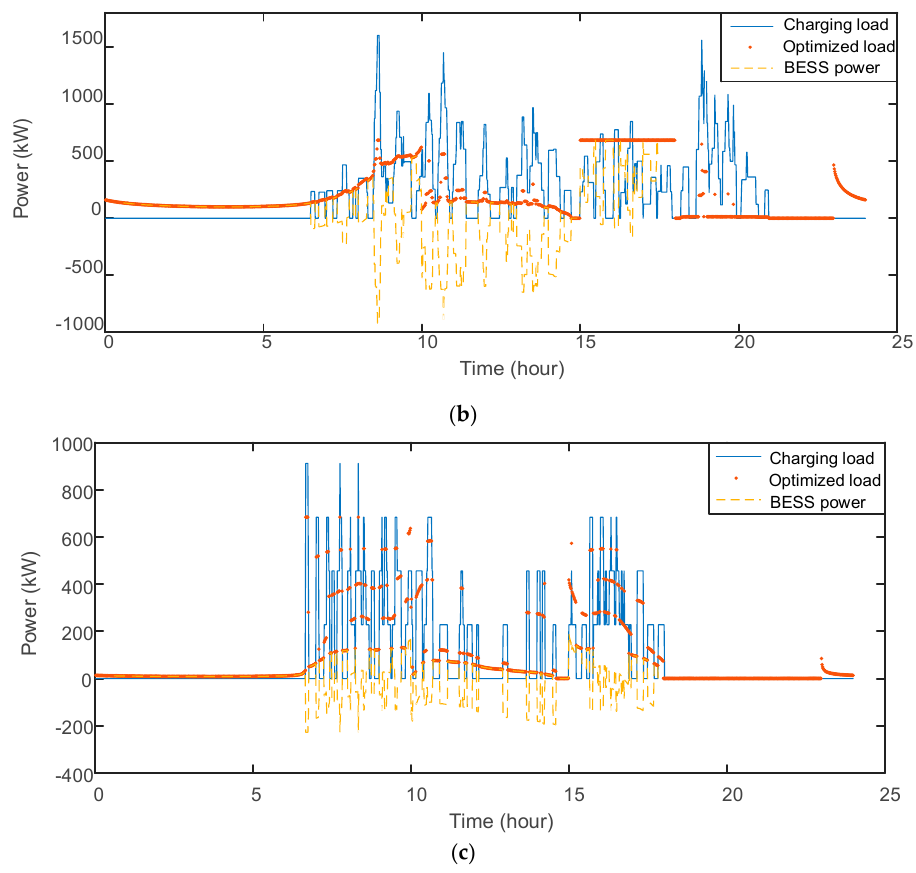
Figure 7 . Charging load and discharging power of BESS. ( a ) The output power of BESS with the original charging load decreased to 912 kW; ( b ) the output power of BESS with the original charging load decreased to 684 kW, and ( c ) the output power of BESS with the optimized charging load decreased to 684 kW.